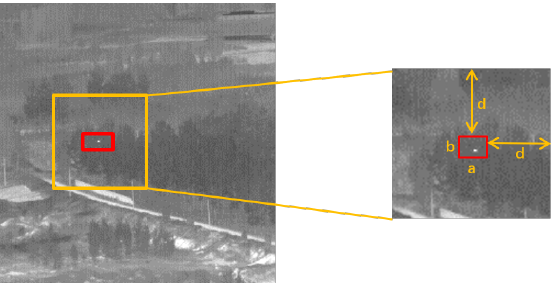
Figure 9. A partial schematic diagram of the target area and the background area around the target.